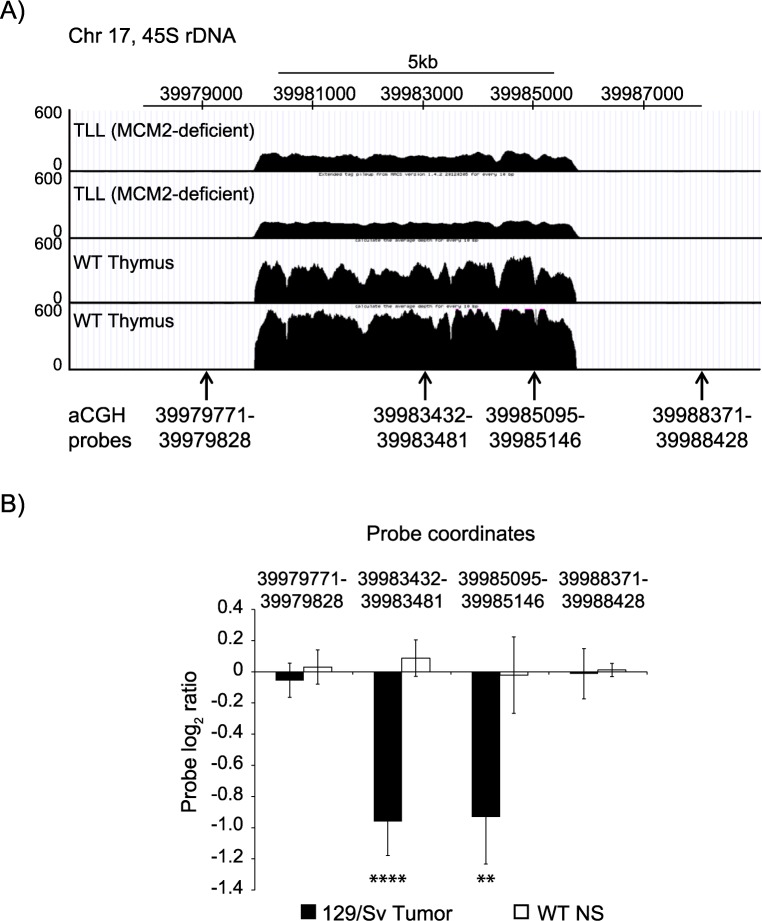
45S rDNA repeats are lost in T-lymphocytic leukemia (TLL) tumors of MCM2-deficient mice.(A) Sequence tag densities (normalized for number of mapped reads) over a portion of the 45S rDNA from 2 TLL tumors arising in Mcm2IRES-CreERT2/IRES-CreERT2 mice on a 129/Sv x C57Bl/6 F1 genetic background and 2 thymuses from wild-type littermates [39]. (B) Average aCGH log2 values for probes from (A) for 8 TLL tumors arising in Mcm2IRES-CreERT2/IRES-CreERT2 129/Sv mice [38] compared to average aCGH log2 values for the same probes from 3 clonally derived neural stem cell cultures from wild-type littermates (WT NS). Error bars indicate standard deviation. Statistical significance (129/Sv tumor vs. WT NS) was calculated using a standard 2 tailed t-test. **—p<0.01, ****—p<0.0001.